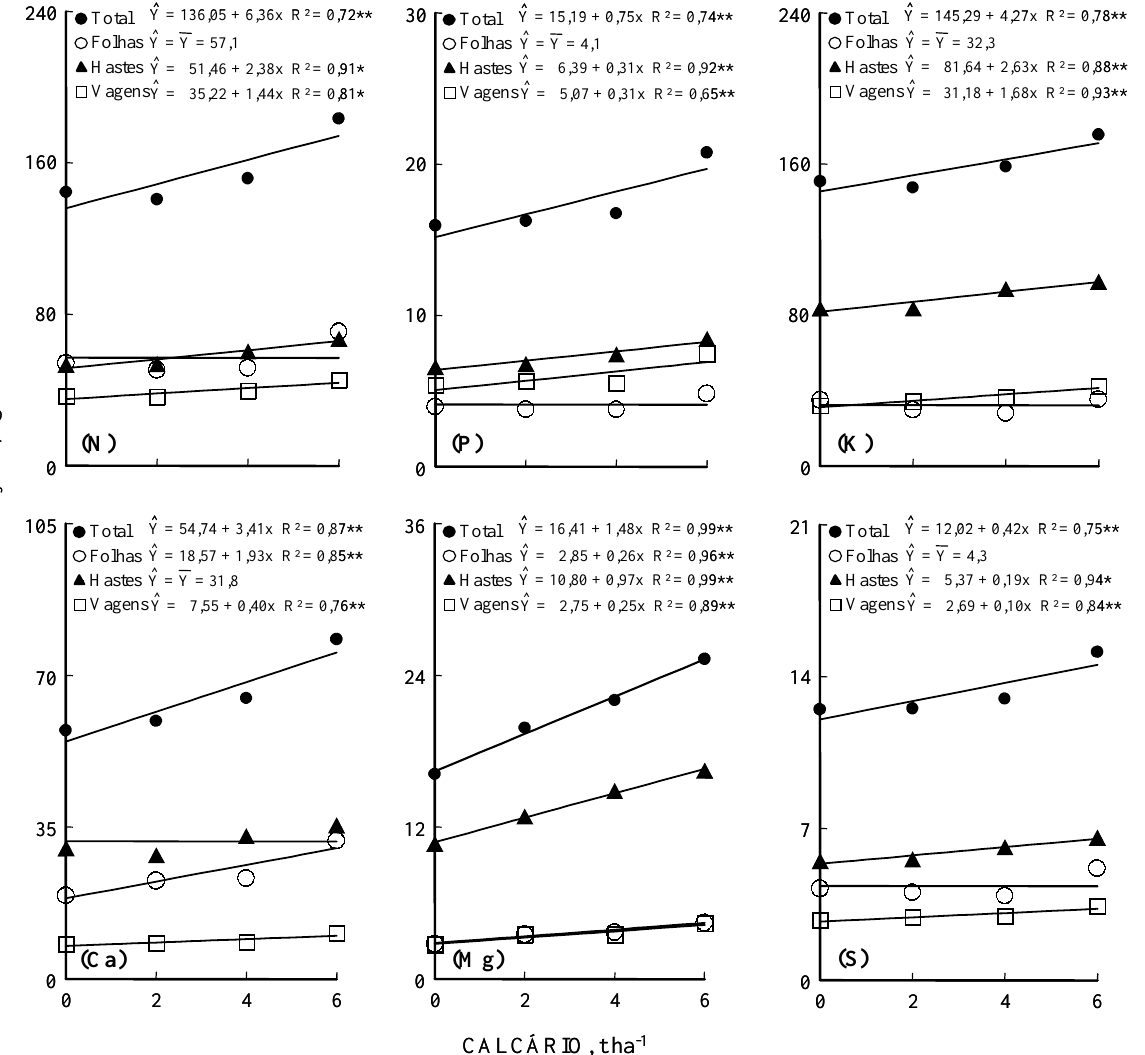
Figura 3. Efeito de doses de calcário na absorção de macronutrientes por diferentes partes da planta de soja. *, ** significativos a 5 e 1%,